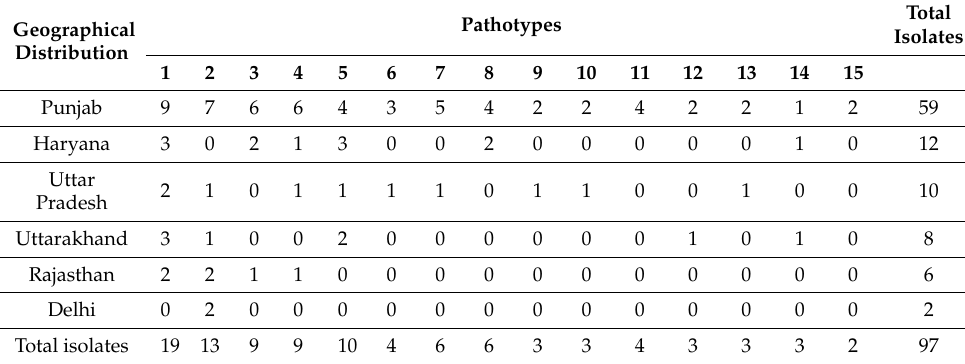
Table 4. Geographical distribution of Fusarium fujikuroi